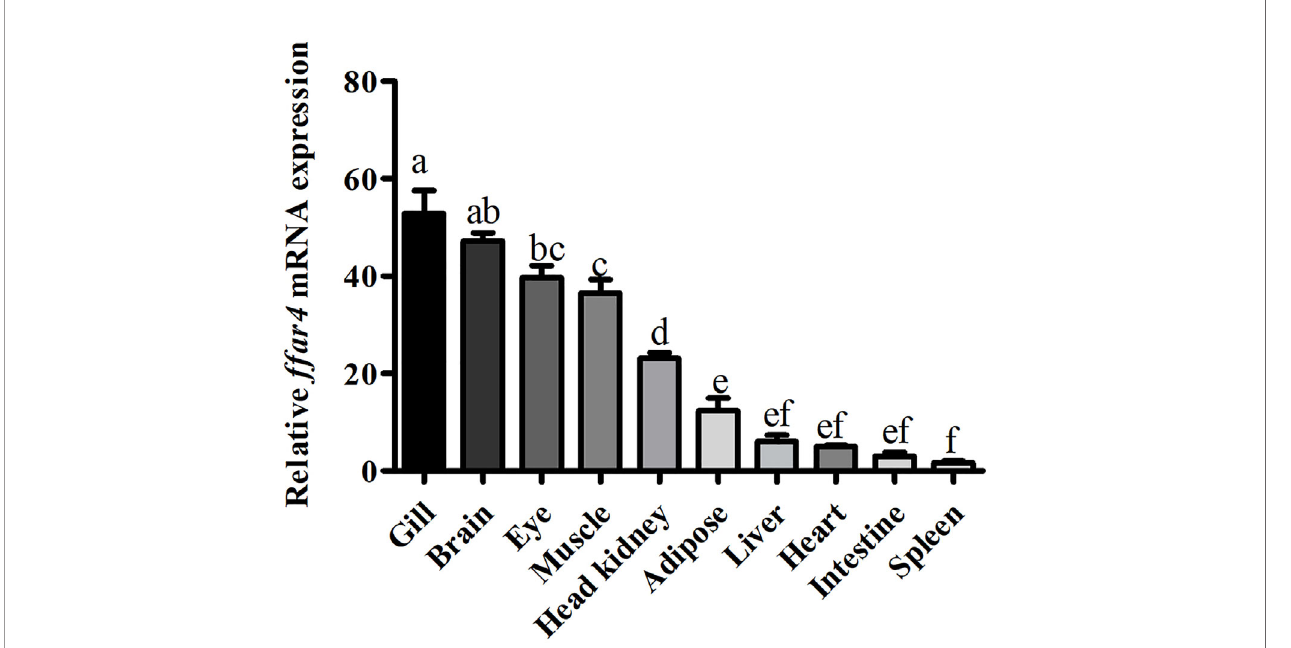
FIGURE 1 | Tissue expression of ffar4 in large yellow croaker. Data were shown as mean ± S.E.M. (n = 4). The same superscript letter means not signi fi cantly different, P > 0.05. Values in bars bearing the same letters were not signi fi cantly different ( P >